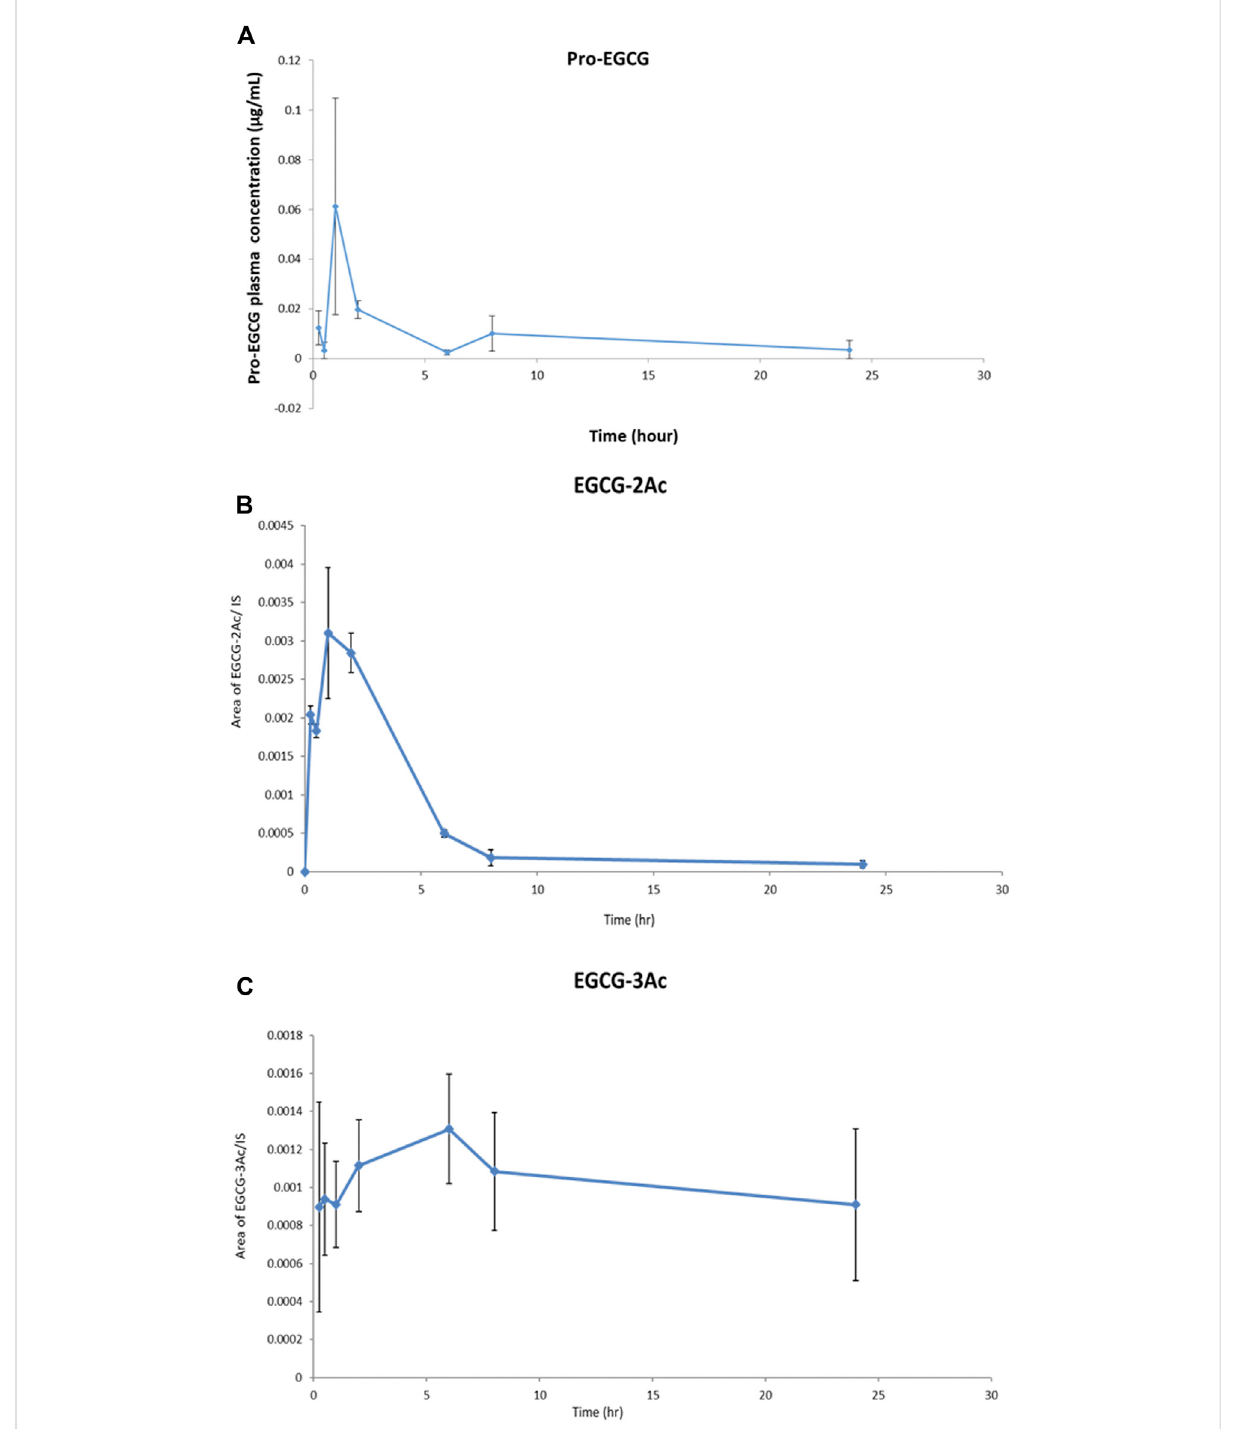
FIGURE 4 The pro fi lesofPro-EGCGand itsmetabolites inplasma. Diagramsshowed thelevelsof (A) pro-EGCG, and itsmetabolites, (B) EGCGdiacetates (EGCG-2Ac), and (C) EGCG triacetates (EGCG-3Ac), ( n = 3) changed over 24 h after intragastric administration of 50 mg/kg pro-EGCG. Each point was mean ±